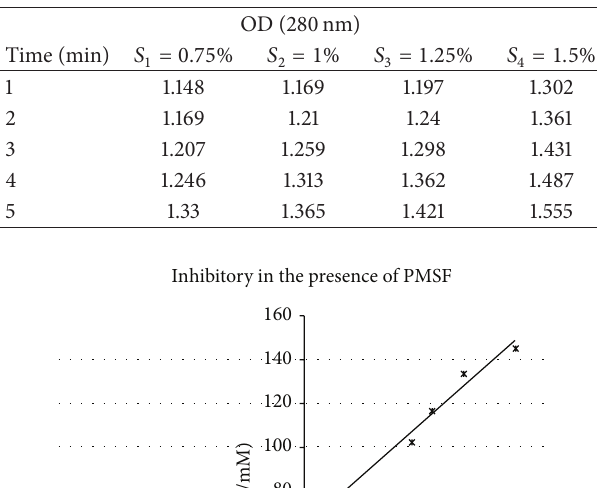
Table 4: The absorbance of the samples in the absence of inhibitor concentrations.